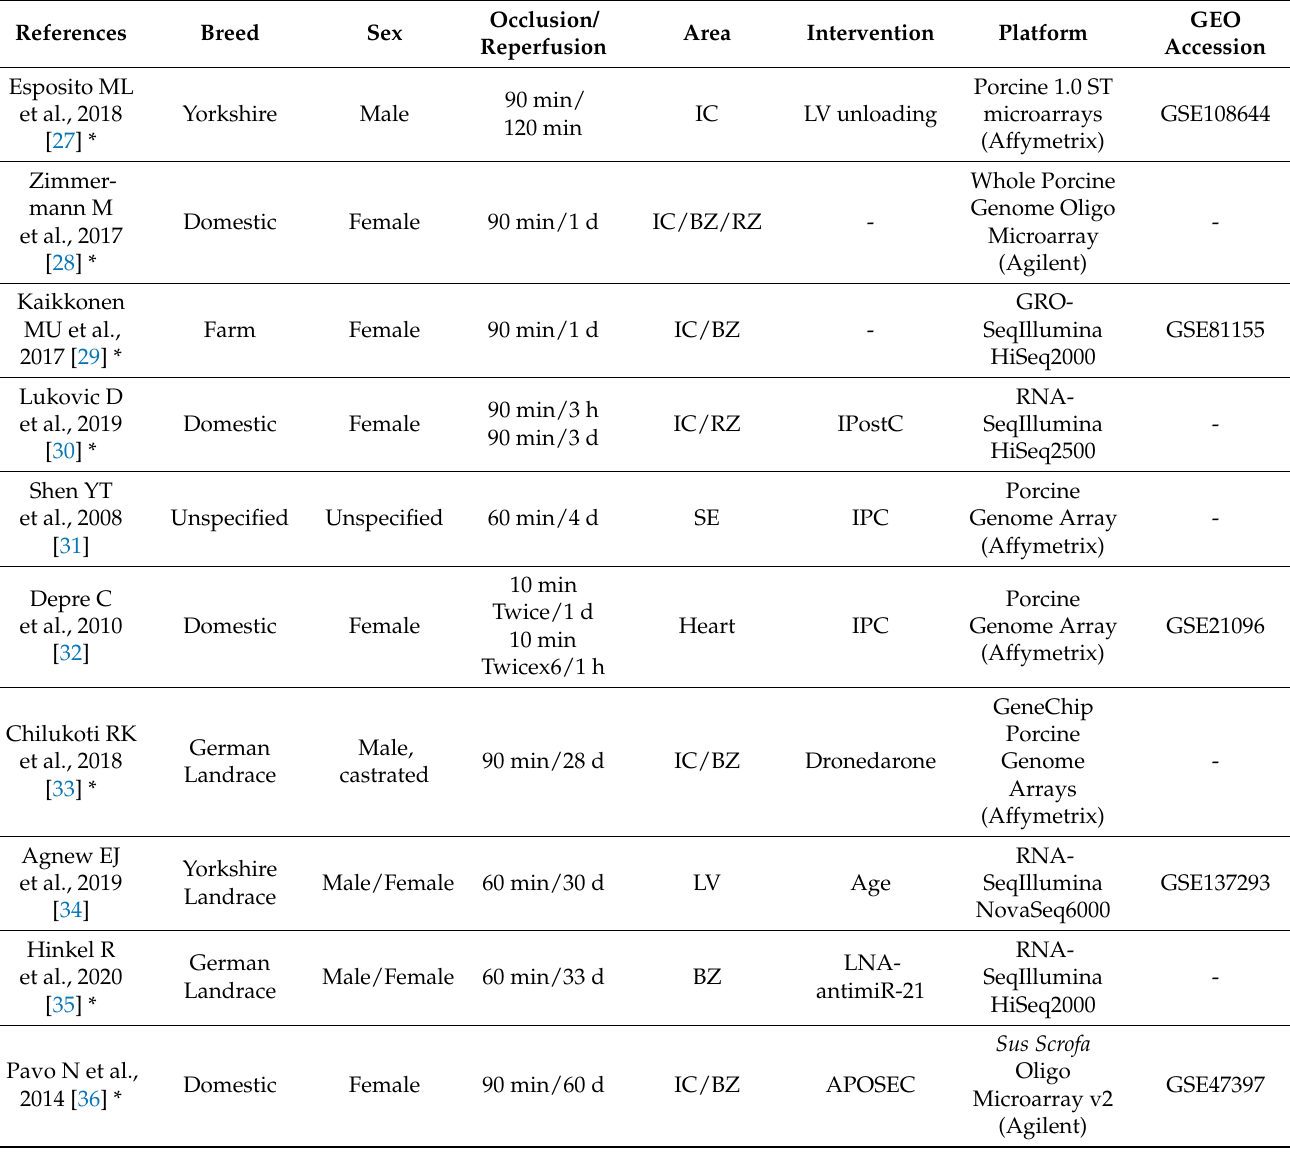
Table 1. Summary of studies included in the systematic